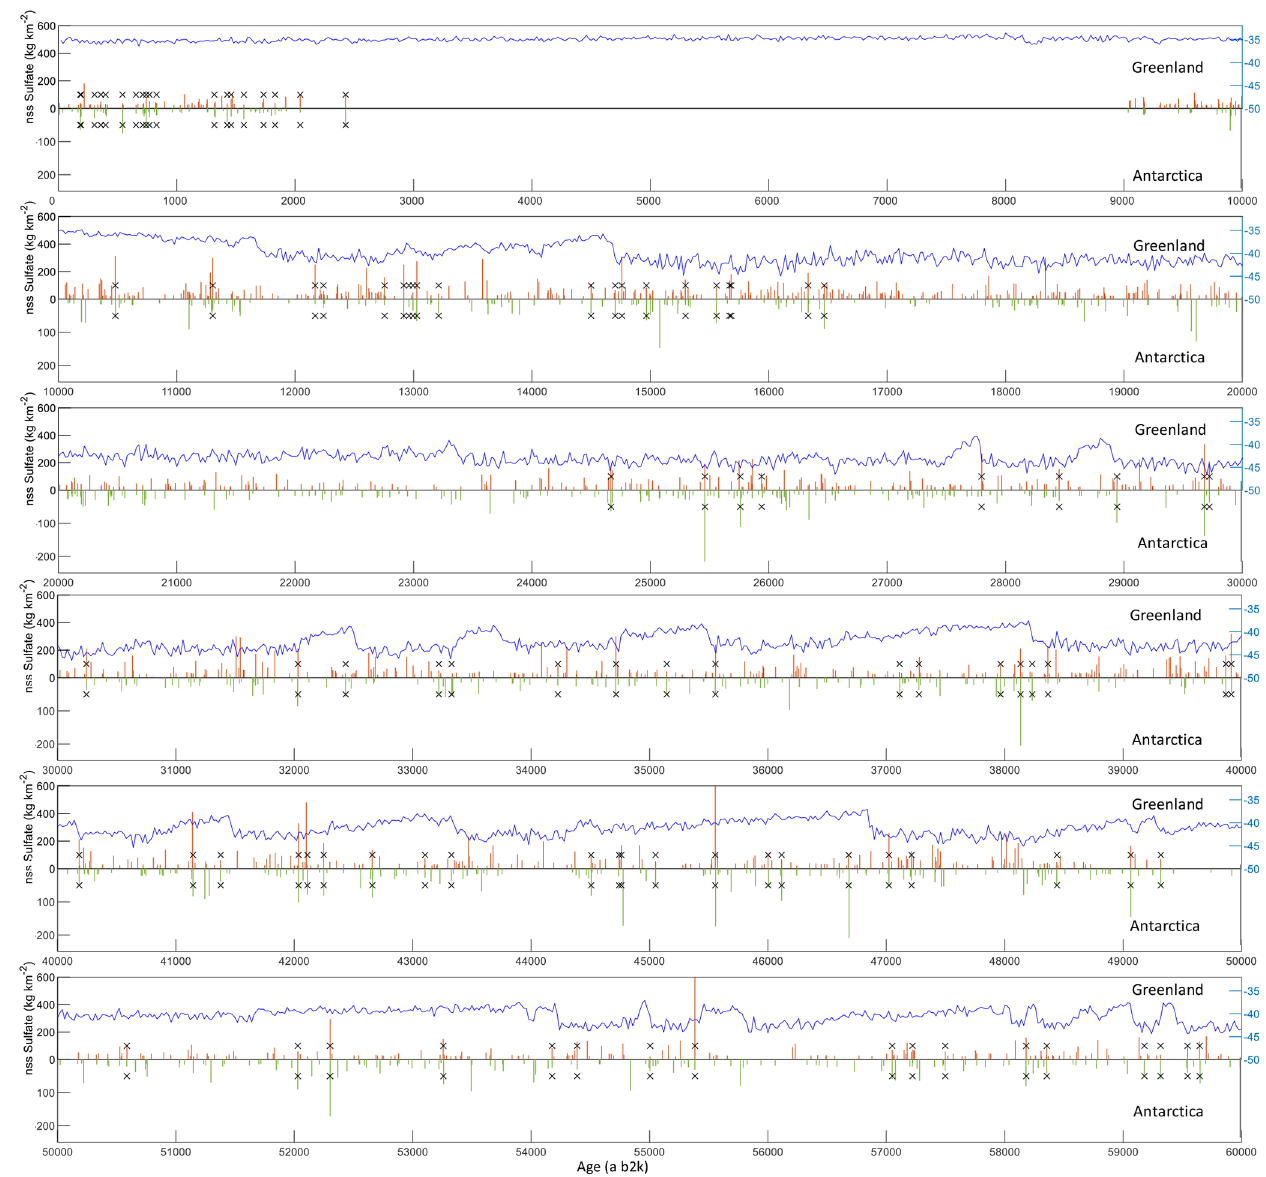
Figure 2. The average volcanic sulfate deposition in Greenland and Antarctica (60–9ka; 2.5–0ka adapted from Sigl et al., 2013, 2015). The blue curve shows δ 18 O of the NGRIP core. Greenland volcanic sulfate depositions larger than 20kgkm − 2 (cyan bars) and Antarctic volcanic sulfate deposition larger than 10kgkm − 2 (black bars) are shown. Bipolar volcanic eruptions are indicated with an